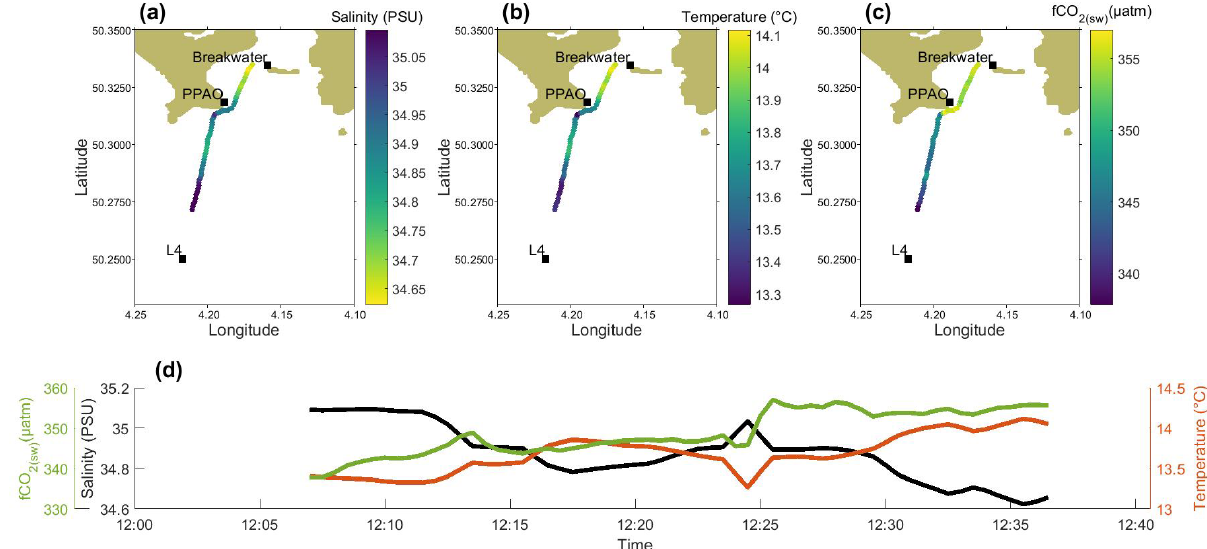
Figure 5. Example of a flooding tide transect (transect midpoint = LW + 3.5h). Surface measurements of salinity, temperature and f CO 2 represented spatially (a–c) and as a time series (d) from station L4 toward the coast. Data were collected aboard RV Plymouth Quest on 15 June 2016, (filled circles, data every